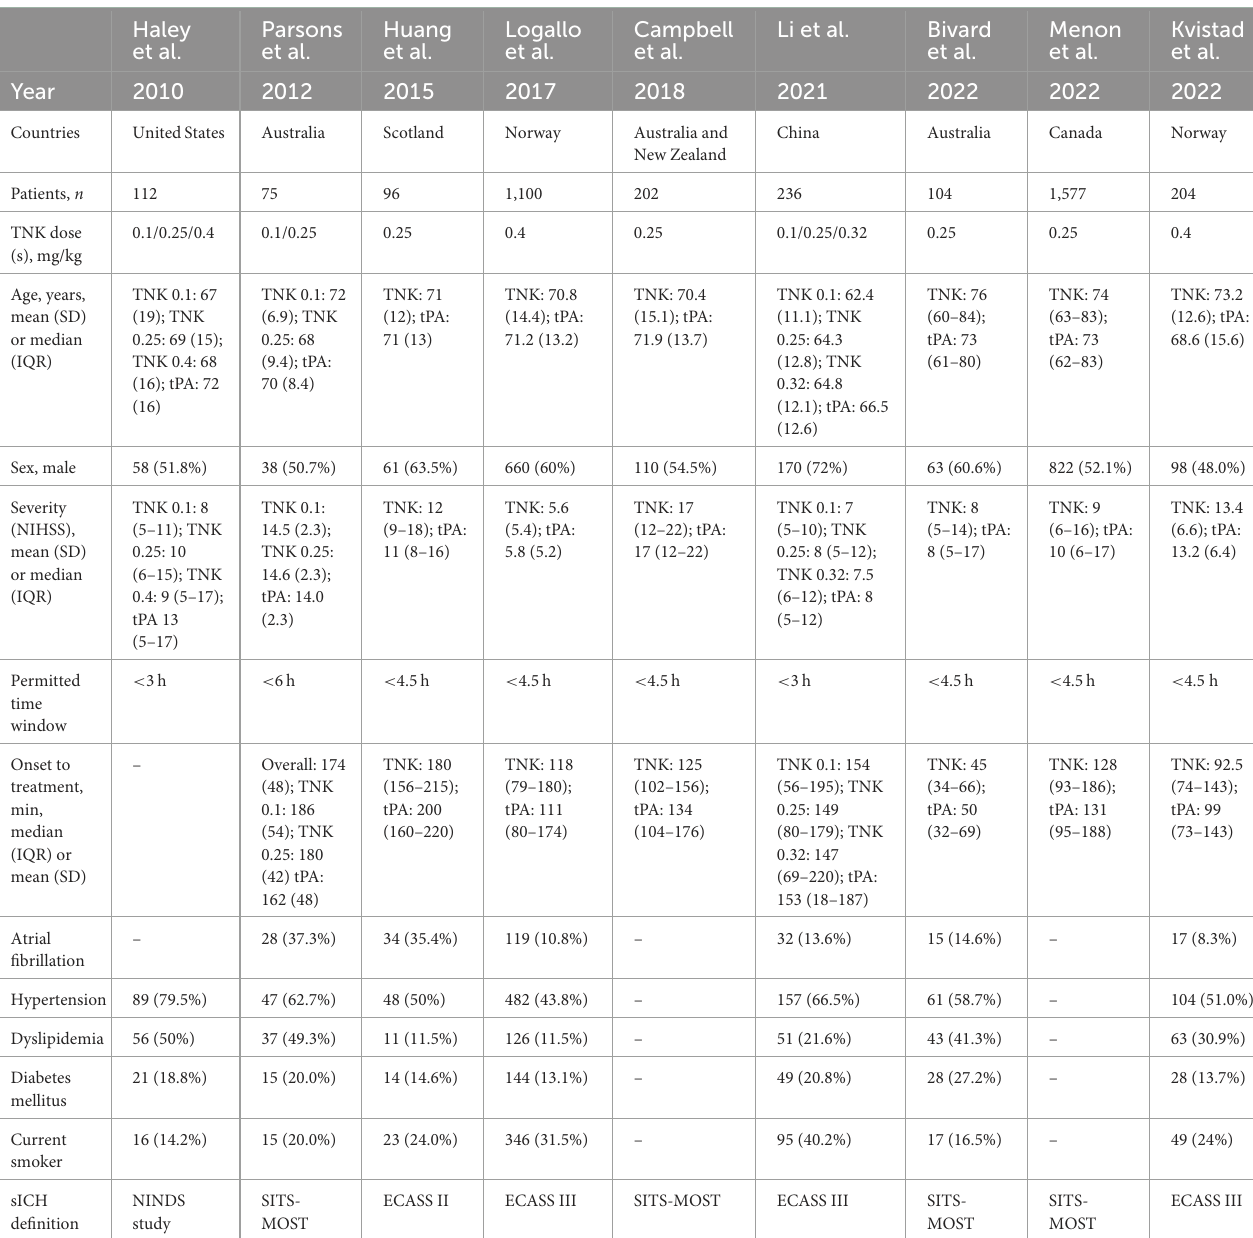
TABLE 1 Characteristics of the included studies.